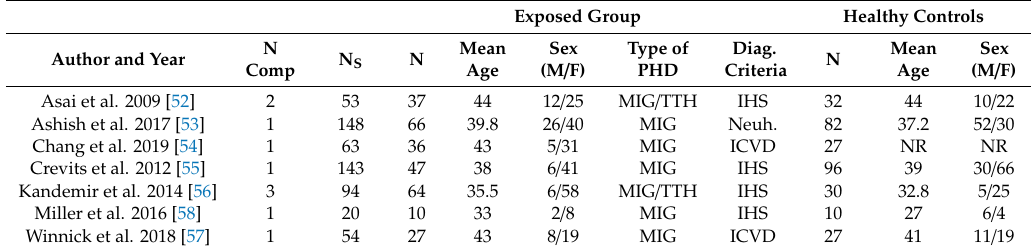
Table 2. Main characteristics of the studies included in the meta-analysis.